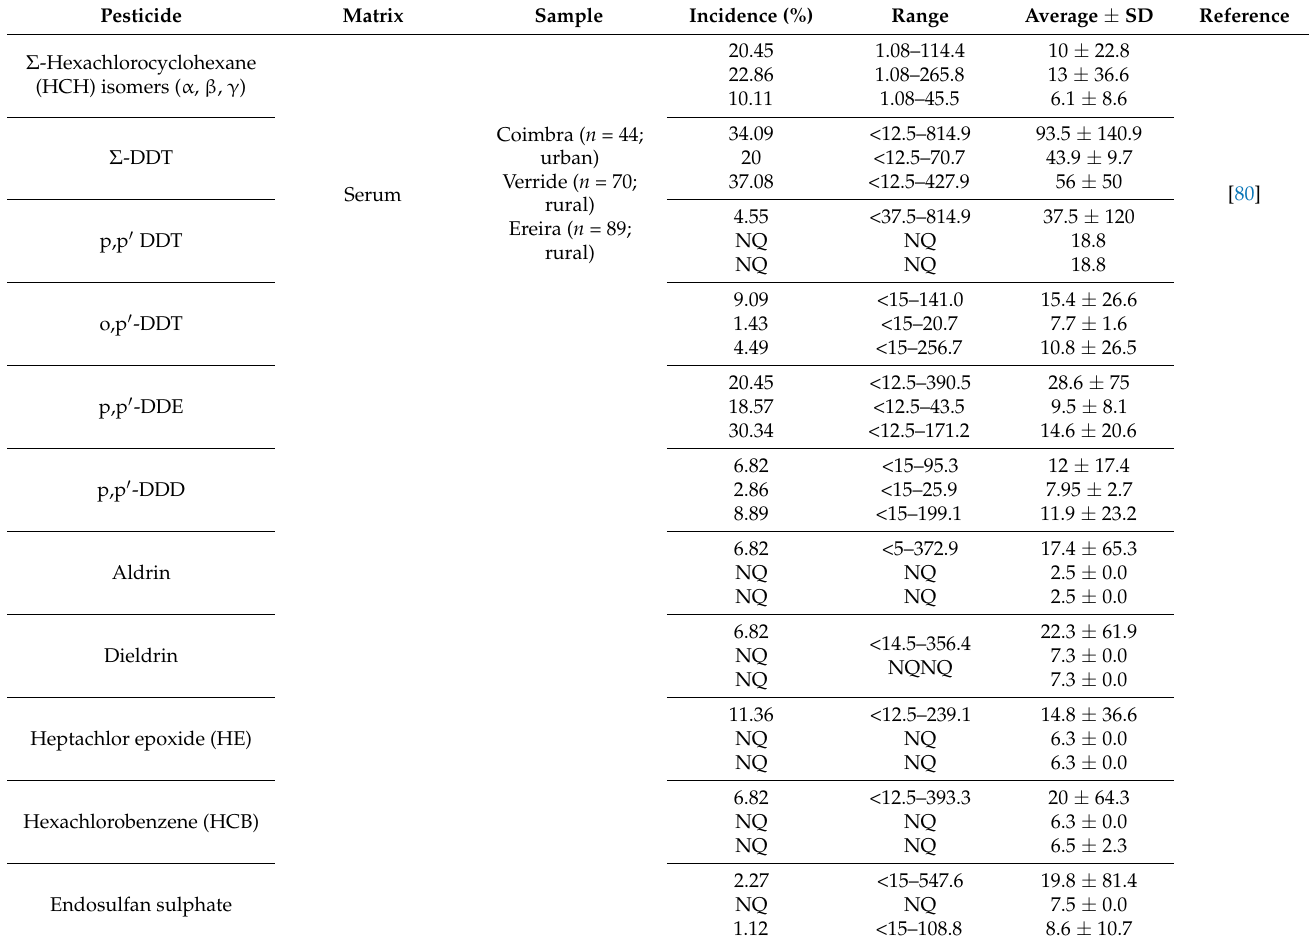
Table 2. Concentrations ( µ g L − 1 ) of pesticides reported in the Portuguese